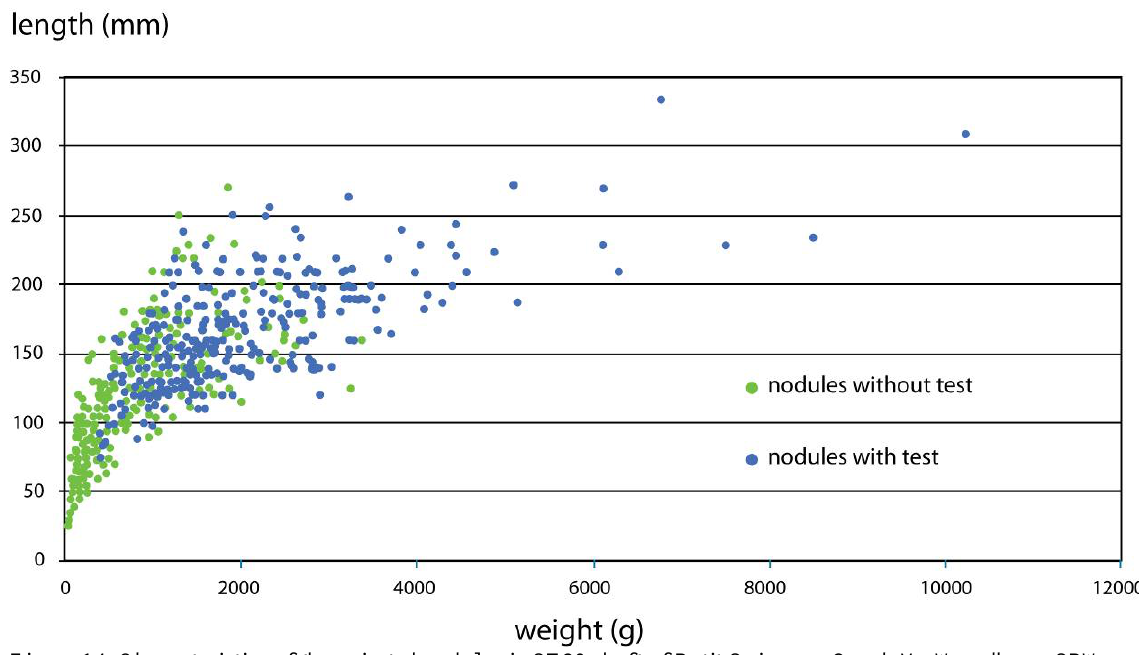
Figure 14. Characteristics of the rejected nodules in ST20 shaft of Petit-Spiennes. Graph M. Woodbury, SPW.